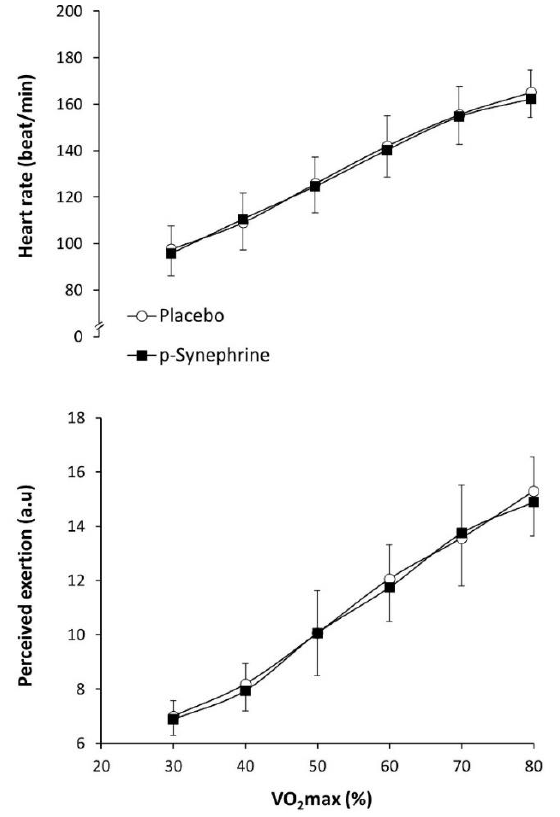
Figure 2. Heart rate and rating of perceived exertion during exercise of increasing intensity after the ingestion of 3 mg/kg of p- synephrine or a placebo in healthy active women.